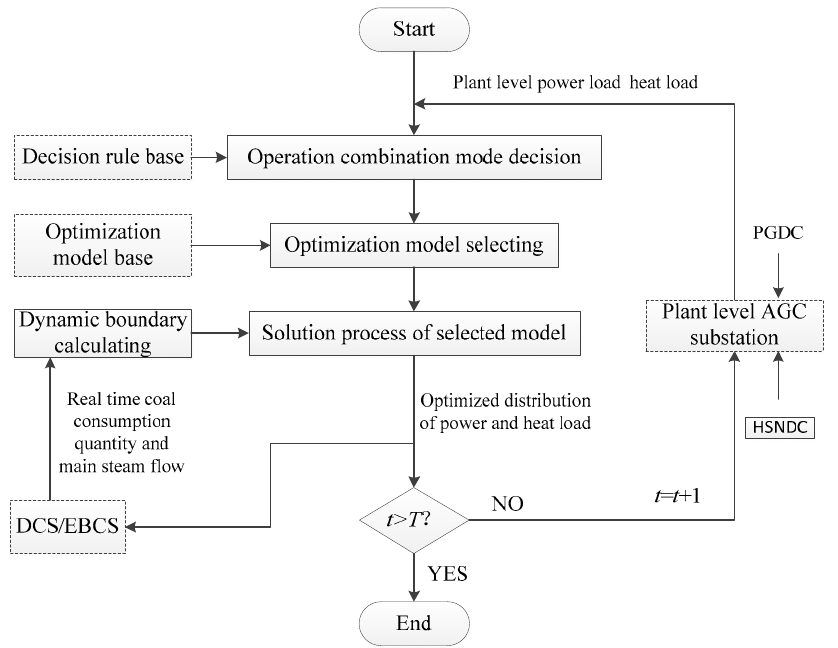
Figure 4. Multi-mode flexible operation optimization process for the CHP plant.